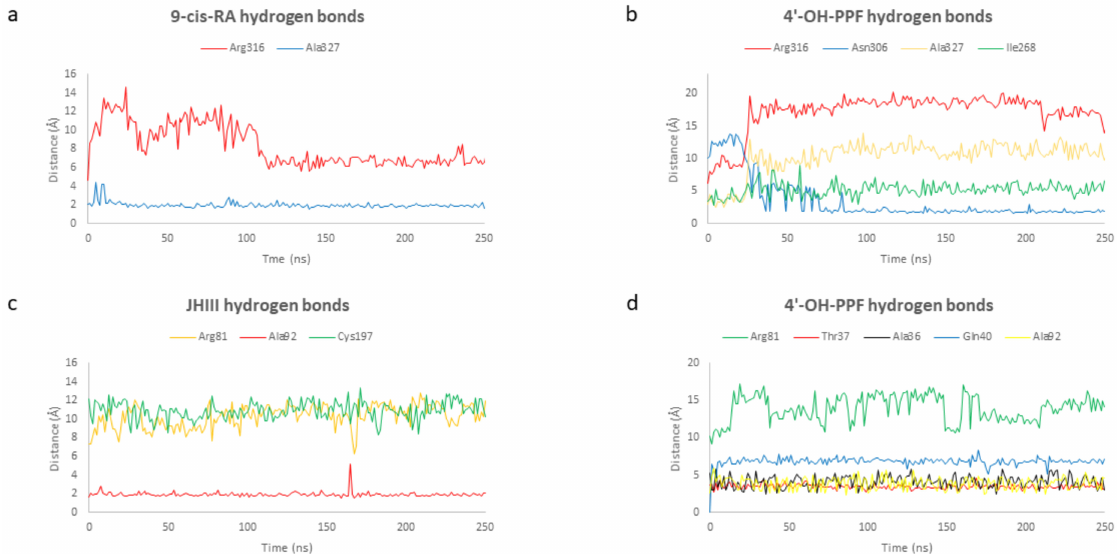
Figure 6. Distances between 9-cis-retinoic acid ( a ) and 4 (cid:48) -OH-pyriproxyfen ( b ) and the residues of RXR α involved in the hydrogen bond interactions with the ligands. Distances between juvenile hormone ( c ) and 4 (cid:48) -OH-pyriproxyfen ( d ) and the residues of USP involved in the hydrogen bond interactions with the